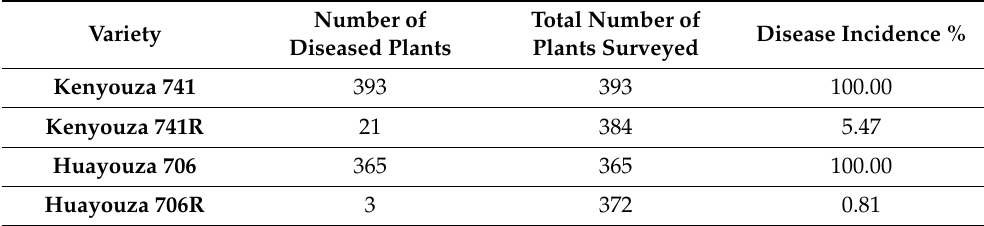
Table 1. Clubroot resistance evaluation of Kenyouza 741R and Huayouza 706R. Number of Total Number of Variety Disease Incidence Diseased Plants Plants Surveyed